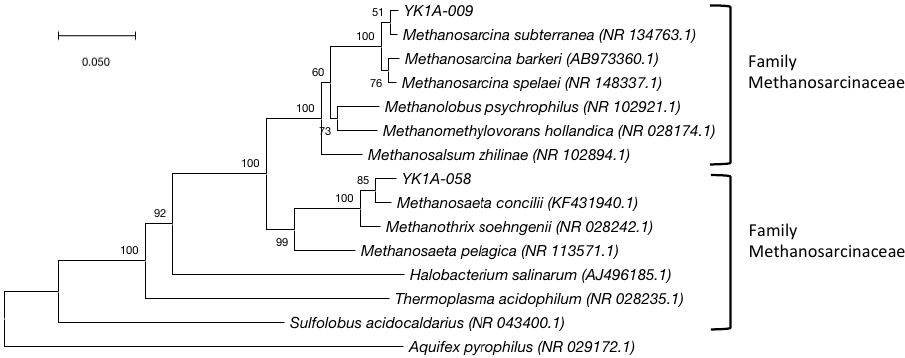
Figure 8. Phylogenetic tree of archaeal clones. The DNA database accession numbers for described species are in parentheses. The bar indicates evolutionally distance. The bootstrap value of each node is indicated.